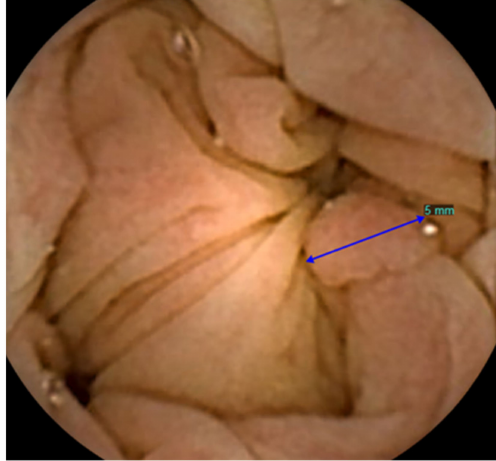
Figure 3. Polyp visualized in